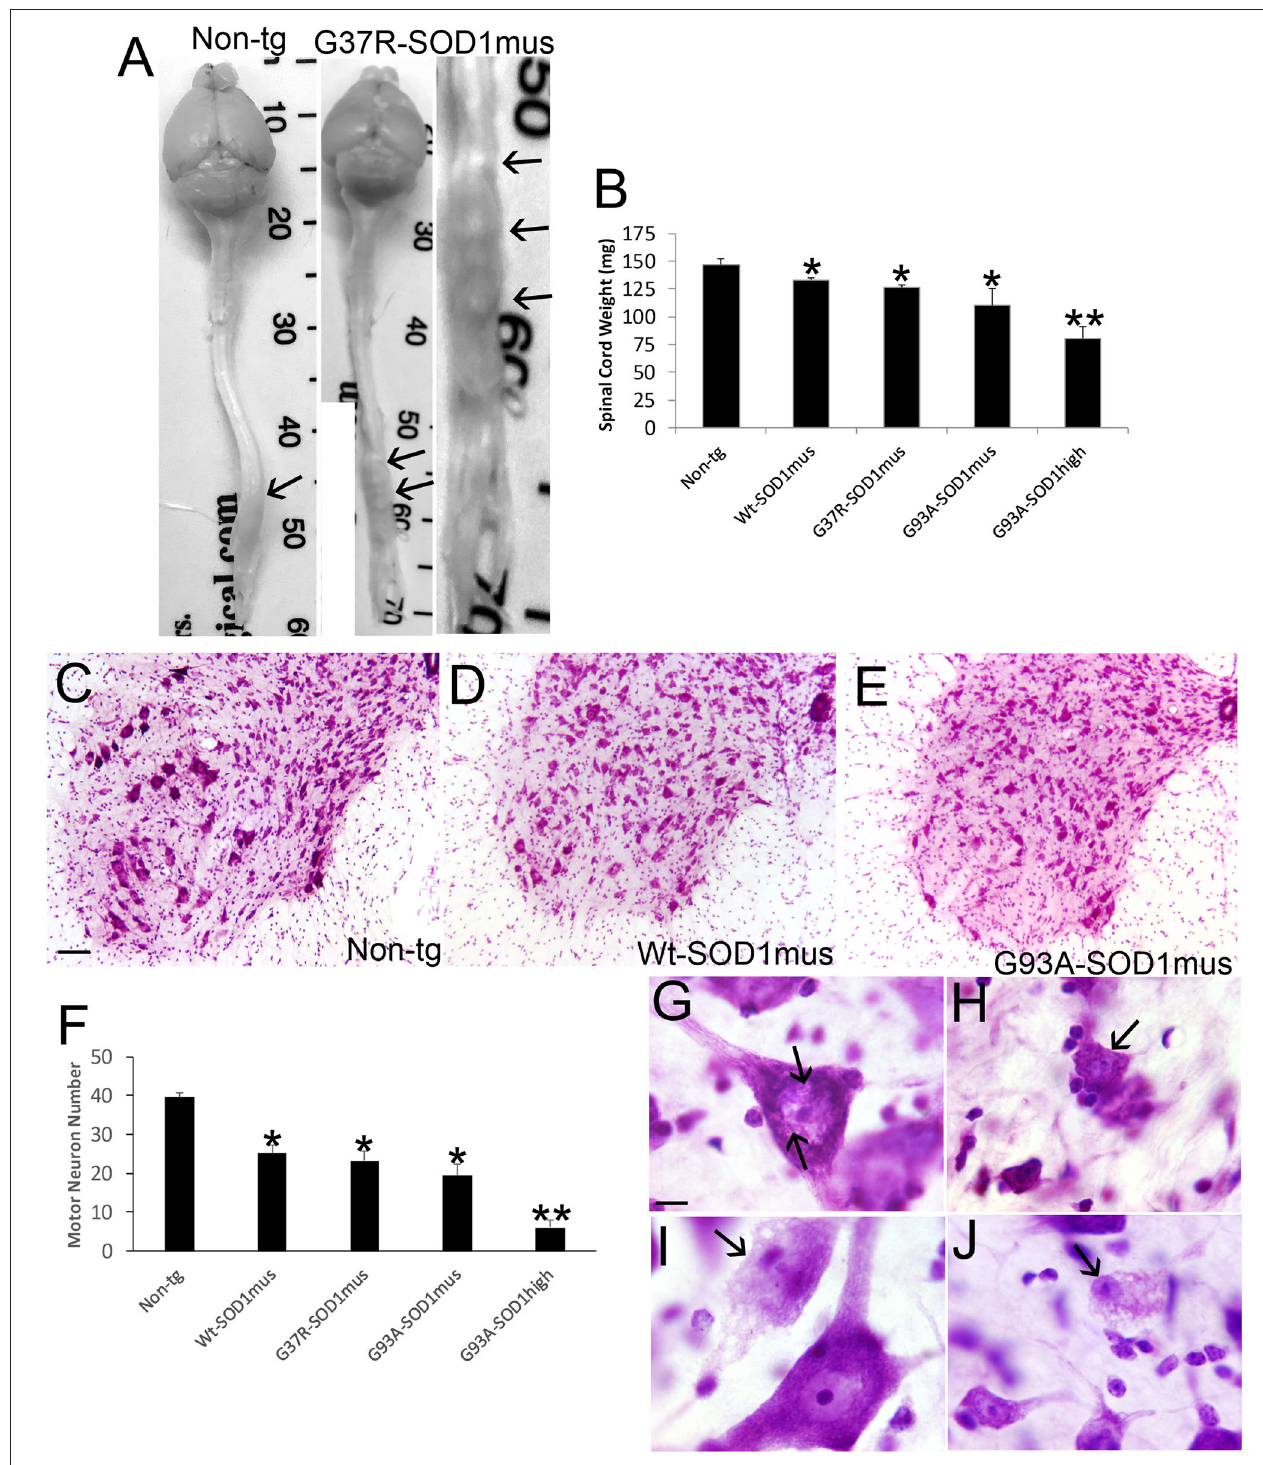
FIGURE 8 | Spinal cord atrophy and motor neuron degeneration occur in hSOD1 mus mice. (A) Isolated brain and spinal cord of age-matched non-tg and G37R-hSOD1 mus mice. Lumbar spinal cord enlargements are identified (arrows). The non-tg cord is smooth and uniformly tapering. The tg cord is irregular, atrophic, and nodular (right panel). (B) Graph of spinal cord weights (mean ± SD) in age-matched non-tg mice and hSOD1 mus mice at endstage disease. Non-age-matched